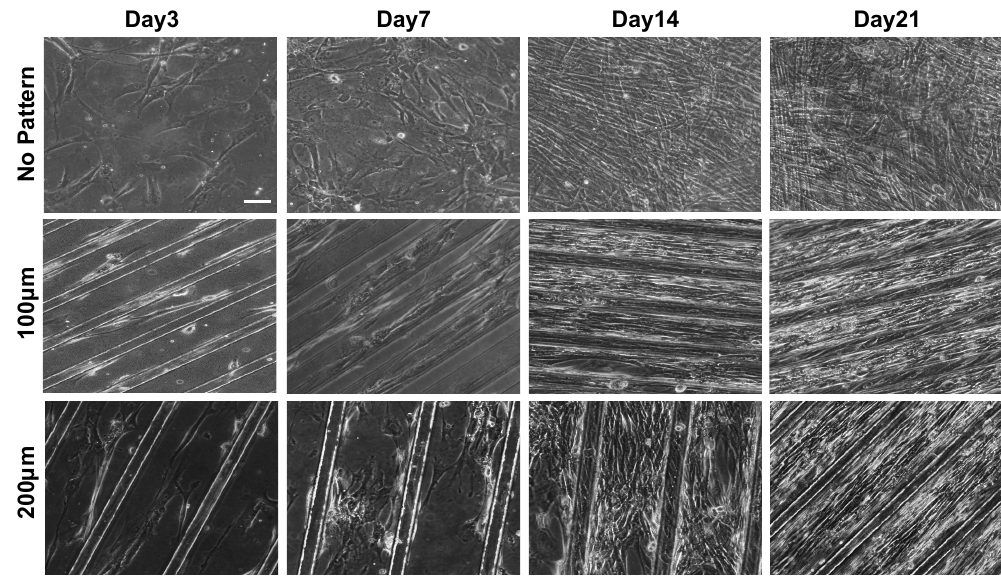
Figure 2. Characterization of cellular morphology of hESC-derived PDGFRA + myogenic progenitor cells cultured on PDMS cell culture substrates with various topographical features. Phase contrast images of PDGFRA + myogenic progenitor cells undergoing myogenic differentiation at different time points (top row—non-patterned substrate; middle row—micropatterned substrates having 100 μ m grooves; bottom row—micropatterned substrates having 200 μ m grooves). Scale bar = 100 μ m.